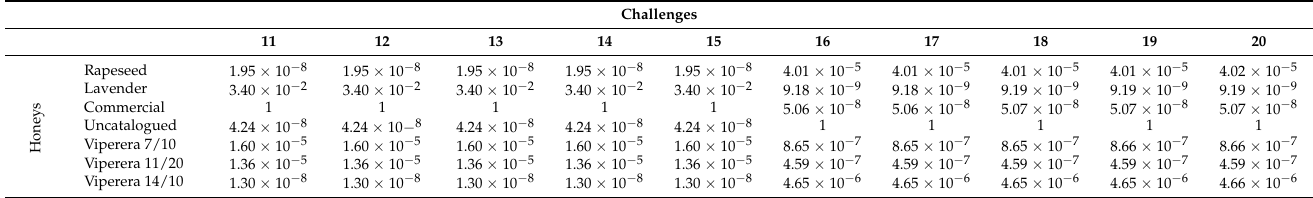
Table 7. Results of the neural network against 35 challenges (from 11 to 20).